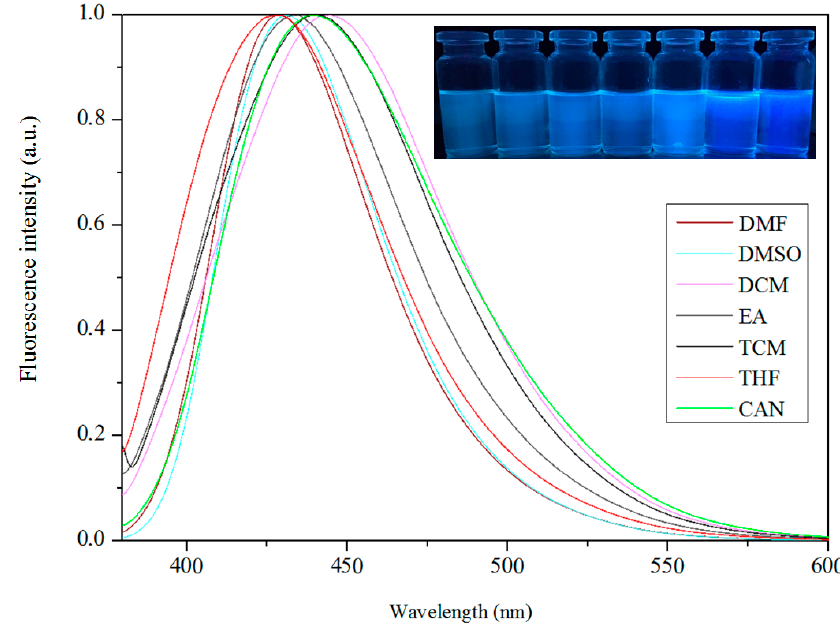
Figure 12. The normalized fluorescent spectra of complex 1 . Inset image: the fluorescence picture of complex 1 in various solvents upon irradiation with a 365 nm UV lamp.